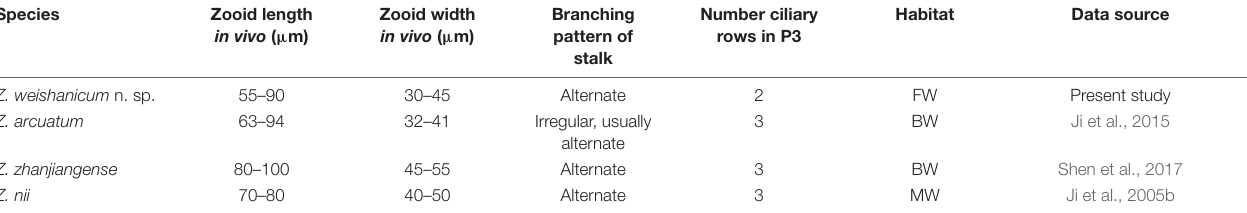
TABLE 4 | Comparison of Zoothamnium weishanicum n. sp. with closely related congeners. Species Zooid length